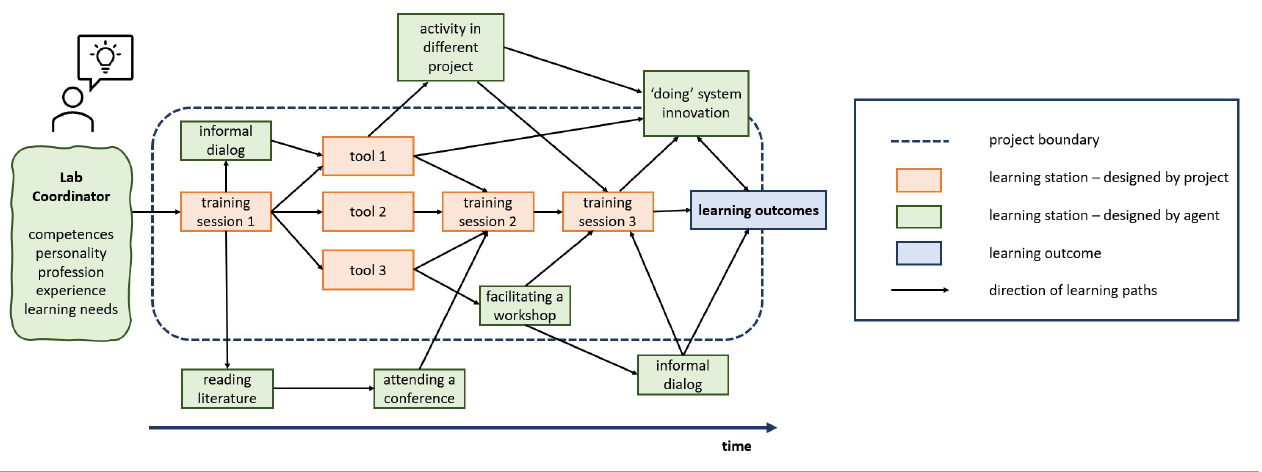
Fig. 2. Schematic visualization of FIT4FOOD2030’s learning system. The learning stations designed by the project are depicted in orange, and the learning stations introduced by the coordinators are depicted in green. The boundaries of FIT4FOOD2030 are visualized by the dotted line, and some potential learning paths of a coordinator are represented by